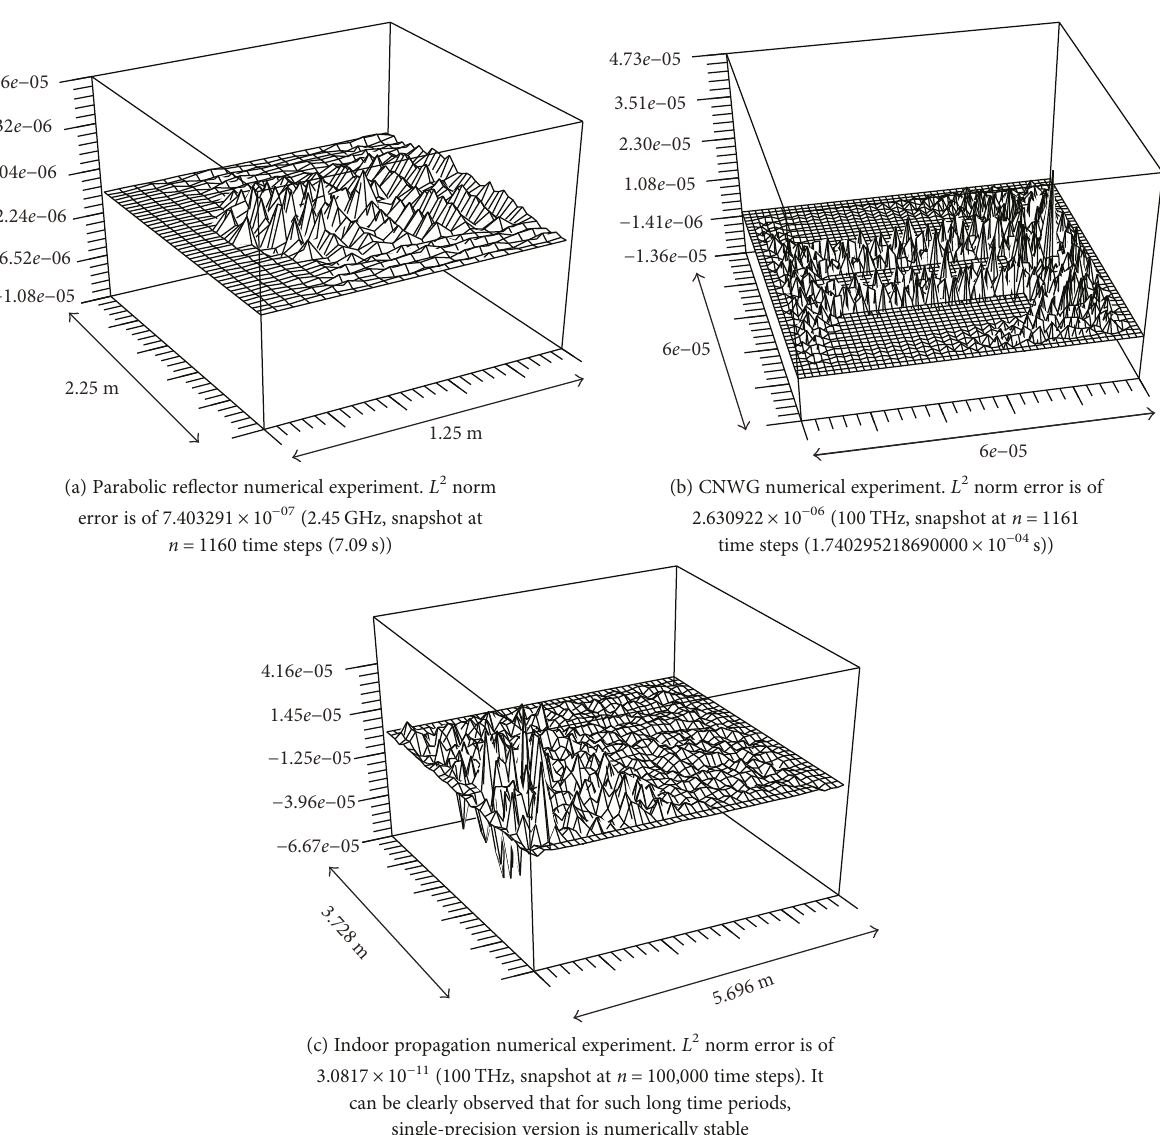
Figure 21: Error induced by single-precision variables with respect to double-precision ones. Table 7: Computing time required in double- and single-precision modes, for the di ff erent numerical experiments, considering CPML and reference